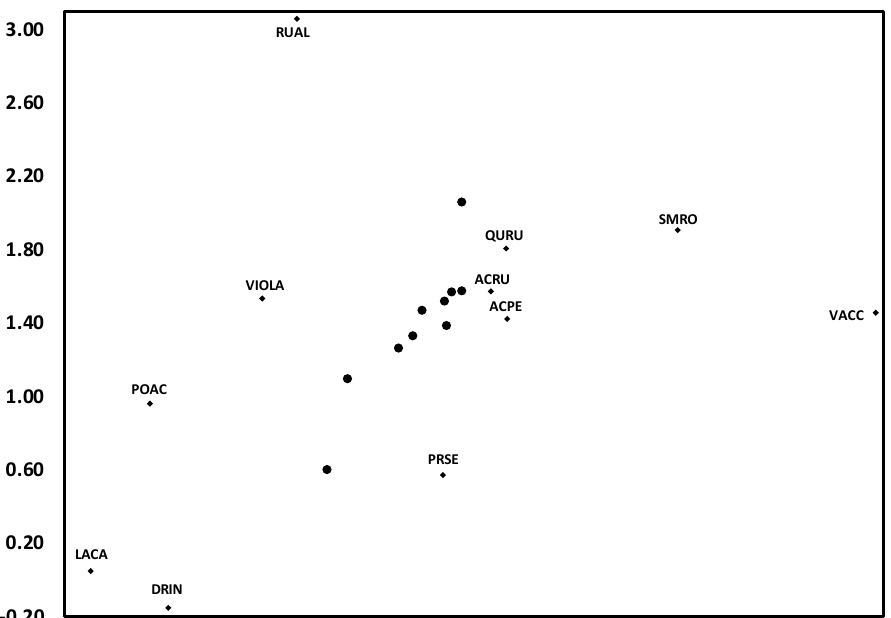
Figure 1. Detrended correspondence analysis (DCA) for herbaceous layer communities from 1991 to 2014 on reference watershed WS4. Data points shown along with years are centroids (two-dimensional means) for each year.